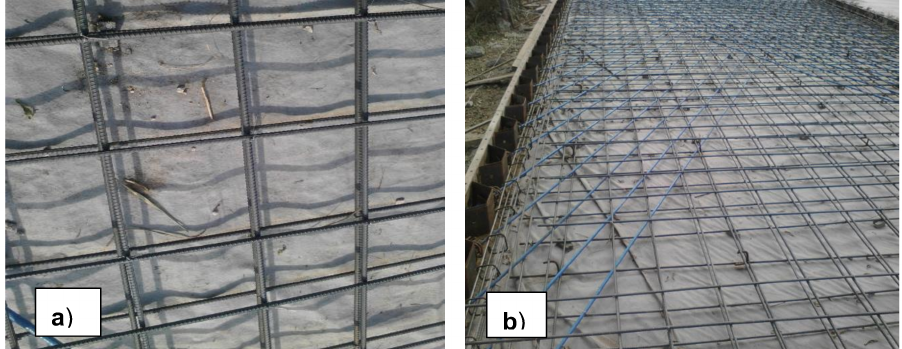
Figure 10. The distribution of reinforcement: ( a ) two-layer regular steel reinforcement; and ( b ) the prestressed reinforcement and the regular reinforcement.